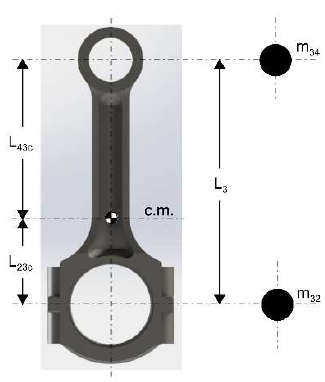
Figure 1. Statically equivalent mass system for connecting rod.